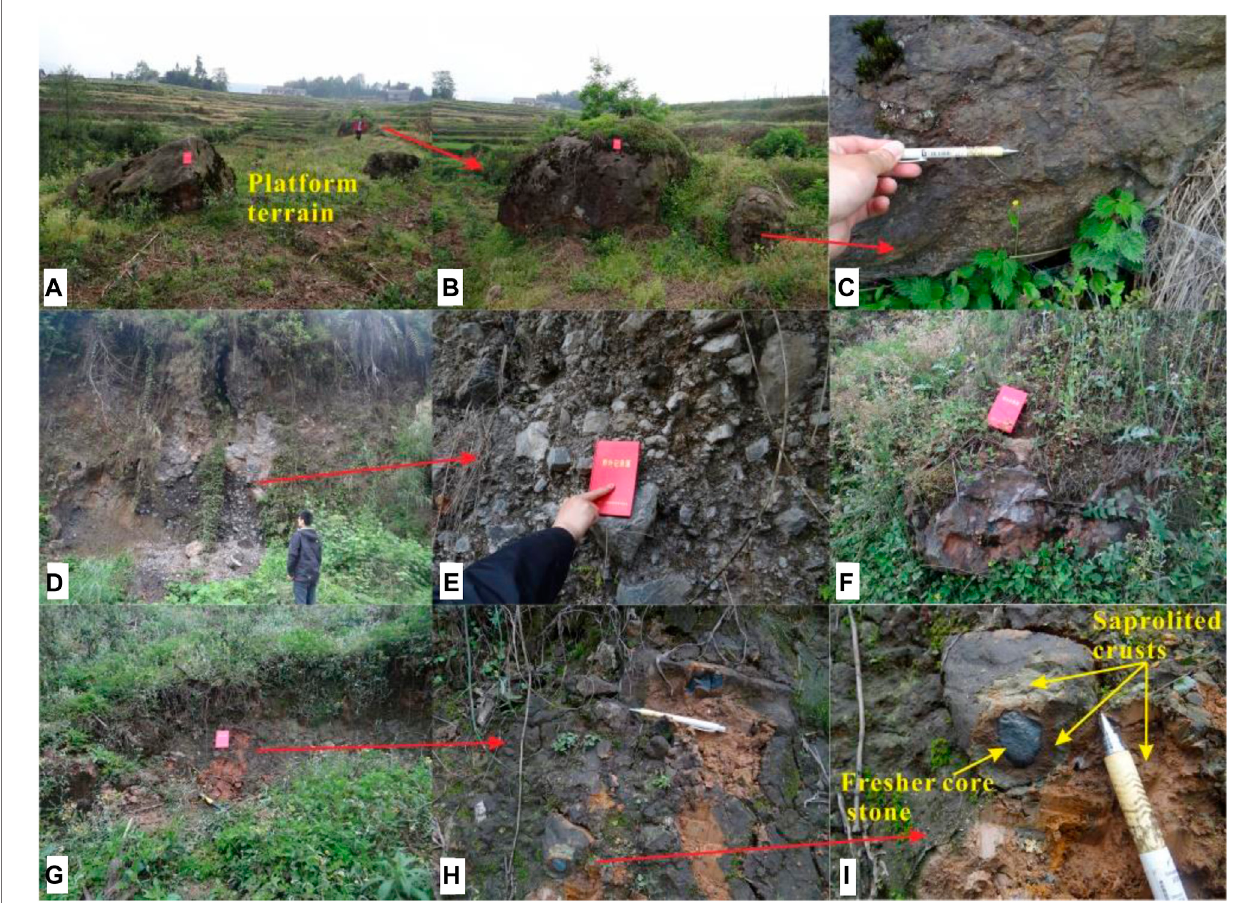
FIGURE 10 | Landslide deposits distributed around Nanmuping Village. (A,B,C) Large basaltic boulders distributed on a platform at observation point D046 (the basaltic blocks show severe argillization). (D,E,F) Landslide deposits at observation point D051. (G,H,I) Large basaltic boulders near observation point D051 are seriously weathered and present the structure of soil sandwiching rock.